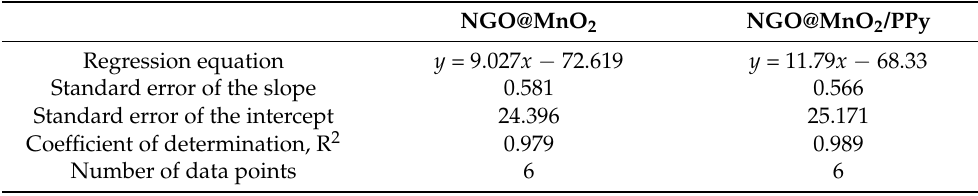
Figure 10. Linearity of ( a ) NGO@MnO 2 and ( b ) NGO@MnO 2 /PPy in the SAW sensor ( T = 20 °C, R.H. = 25–30%). Table 3. Data of the calibration curve for the SAW sensor